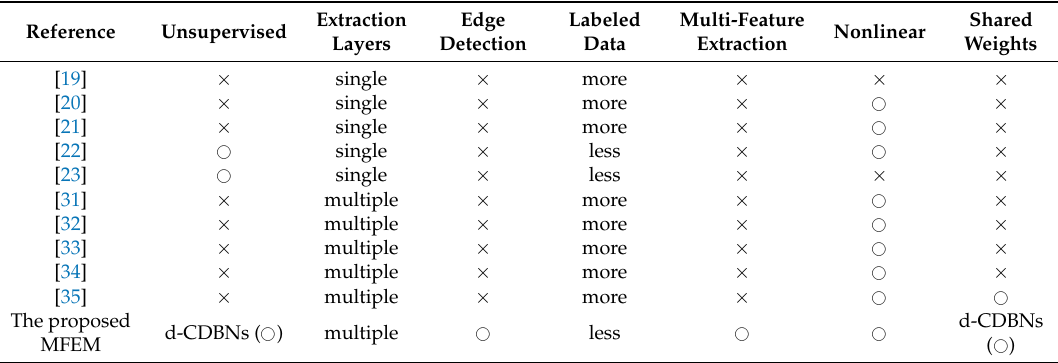
Table 1. Comparison between our model and commonly used